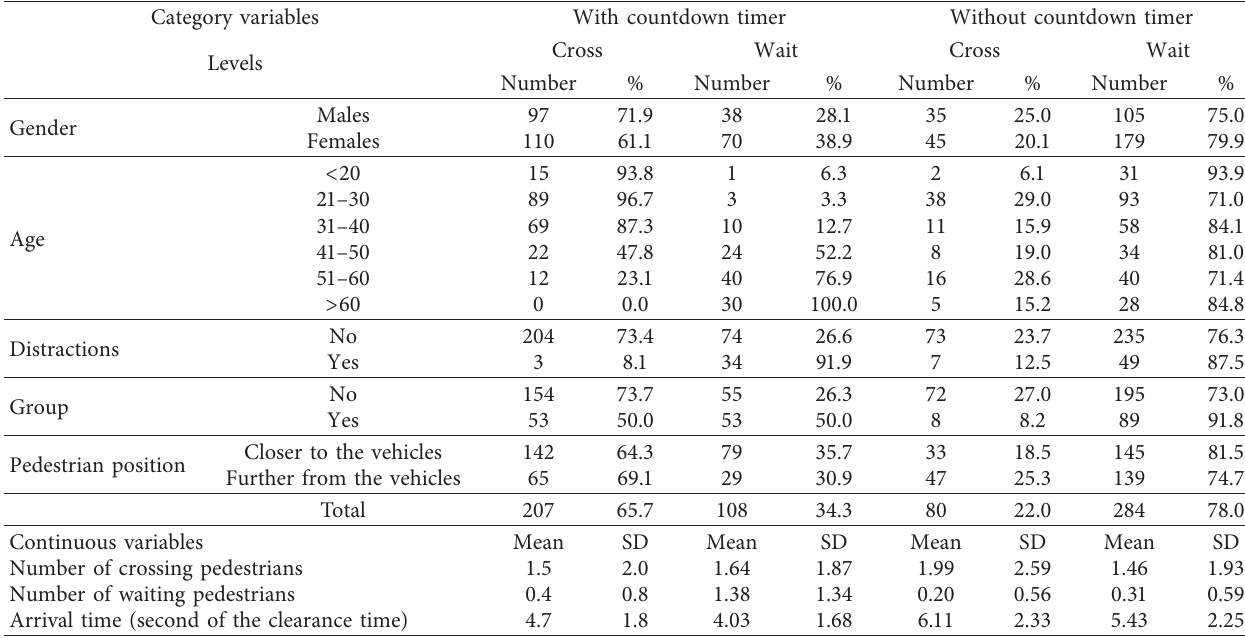
Table 2: Descriptive